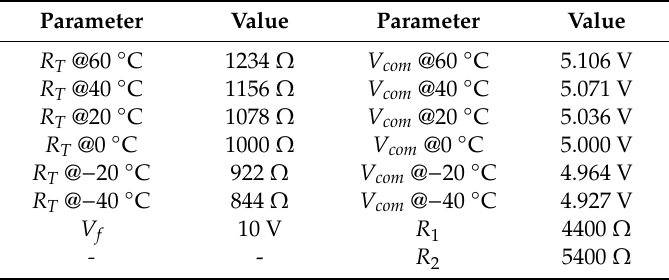
Table 3. MEMS gyroscope scale factor temperature compensation circuit parameters.